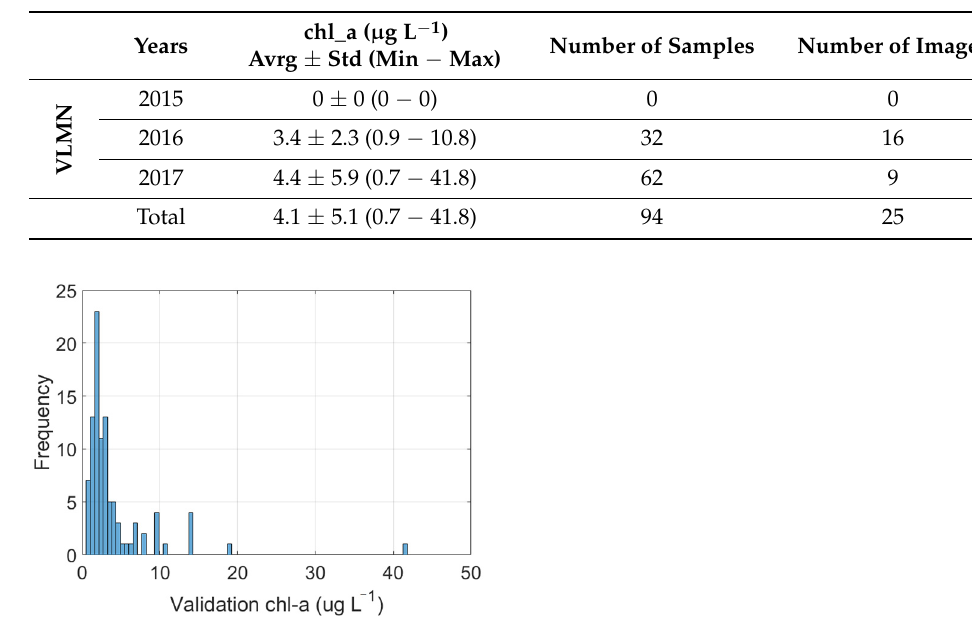
Figure 8. Histogram of the calibration dataset (N = 94).